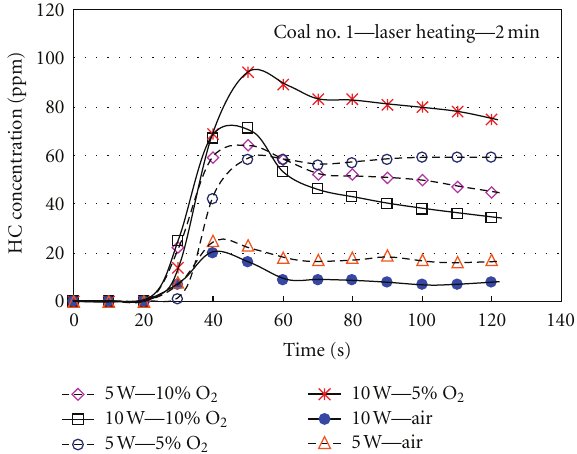
Figure 10: HCs gas generated in CO 2 -rich and air atmospheres.